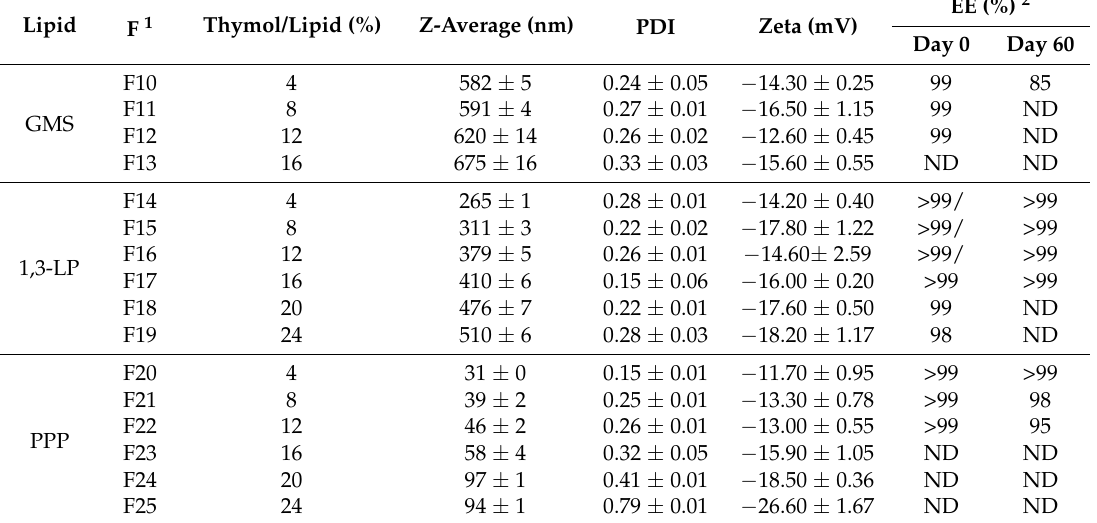
Table 2. The Z-average mean diameter (Z-average), PDI, zeta-potential (Zeta), and encapsulation efficiency (EE%) for the thymol loaded GMS-, 1,3-LP-, and PPP-SLN. Lipid F